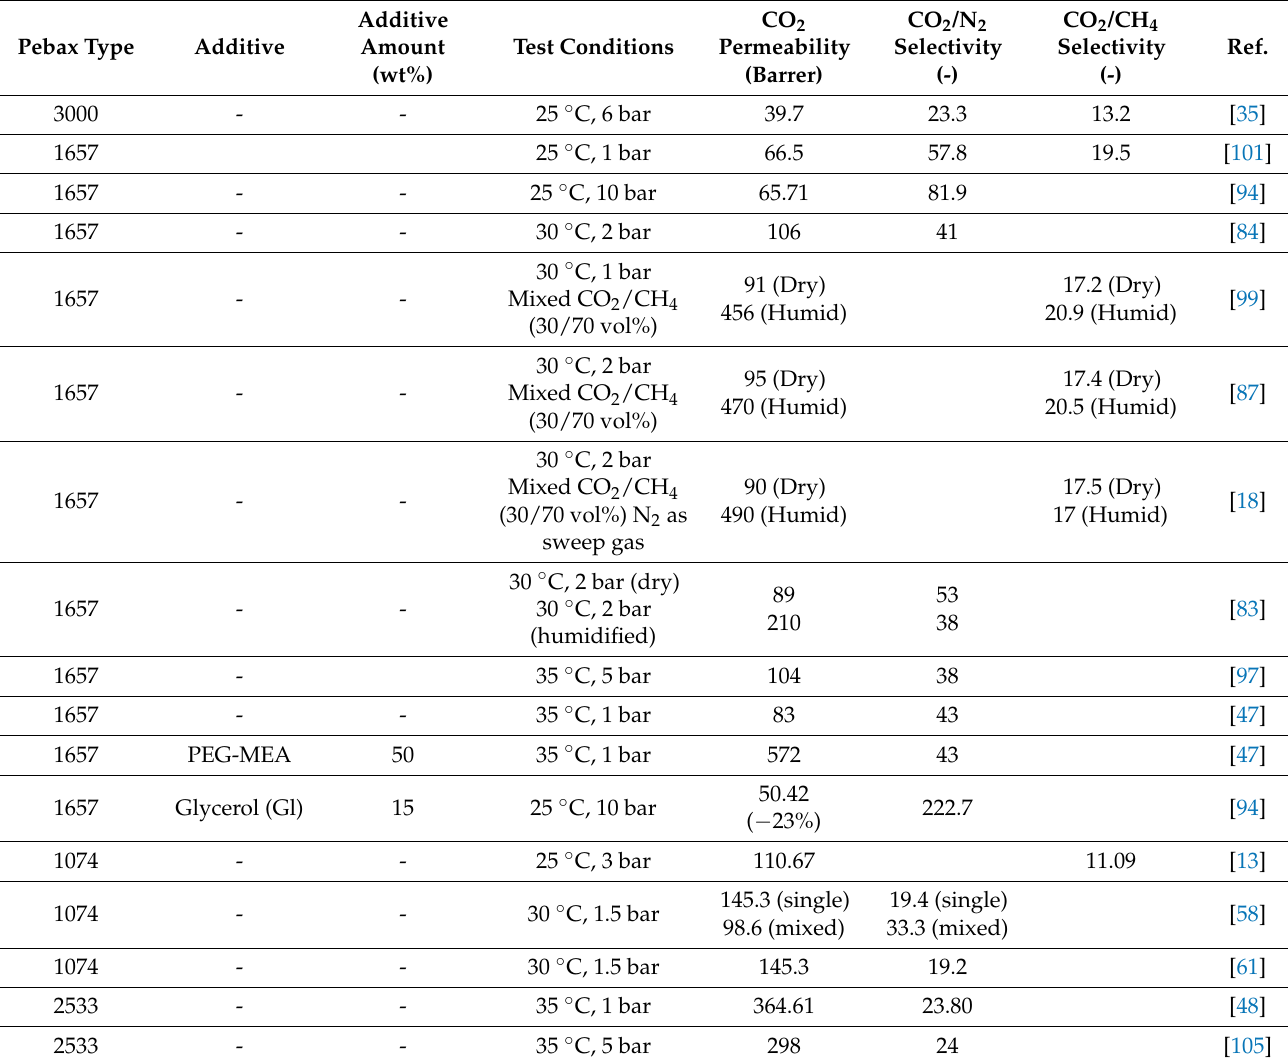
Table 3. Permeation properties of selected Pebax